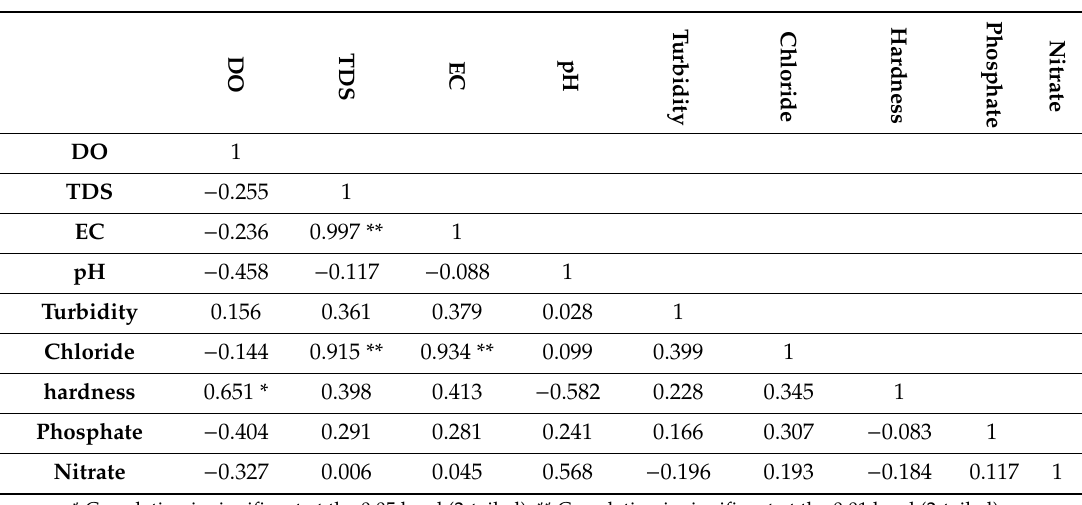
Table A2. Pearson’s linear Correlation Correlations matrix.